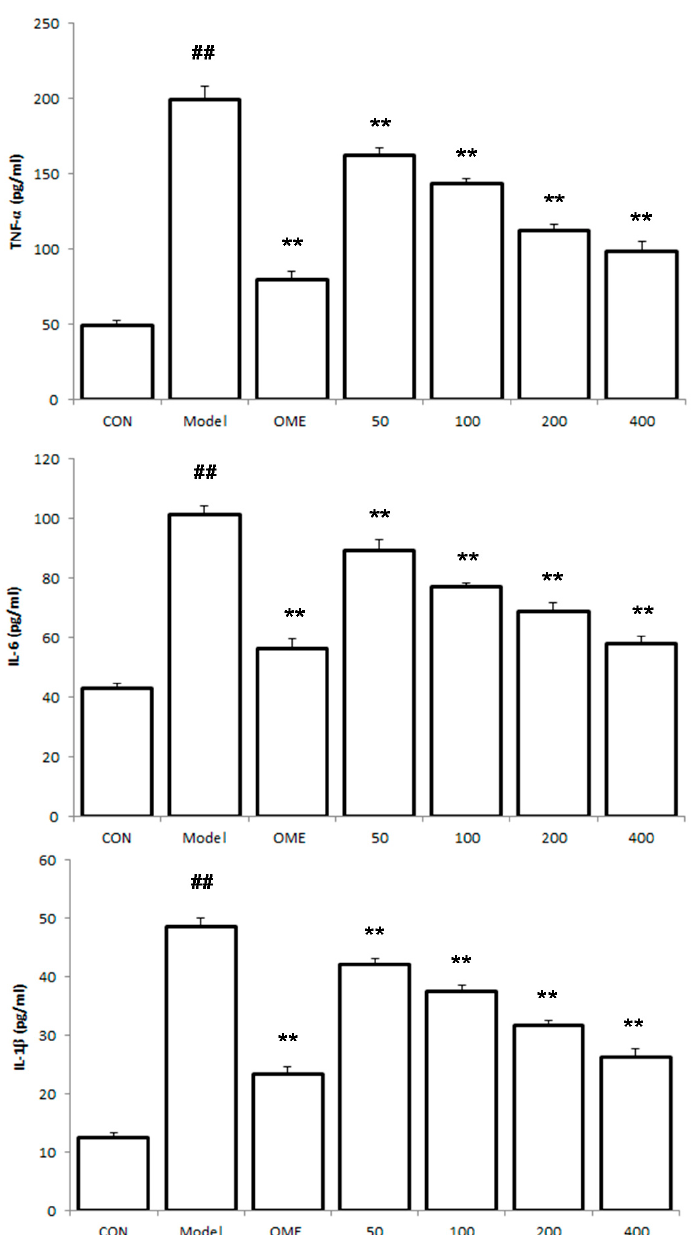
Figure 4. Effect of LCA on MDA, SOD and GSH levels. Data are expressed as the mean ± SD ( n = 8). ##: p < 0.01 vs. control group. **: p < 0.01 vs. model group. (CON = control; OME = omeprazole).